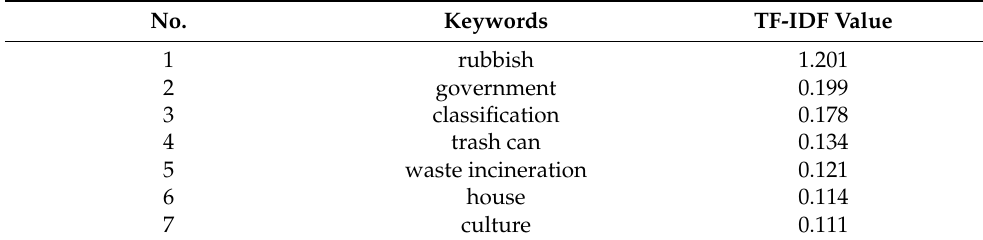
Table 1. Keyword extraction from “Philosophy in the